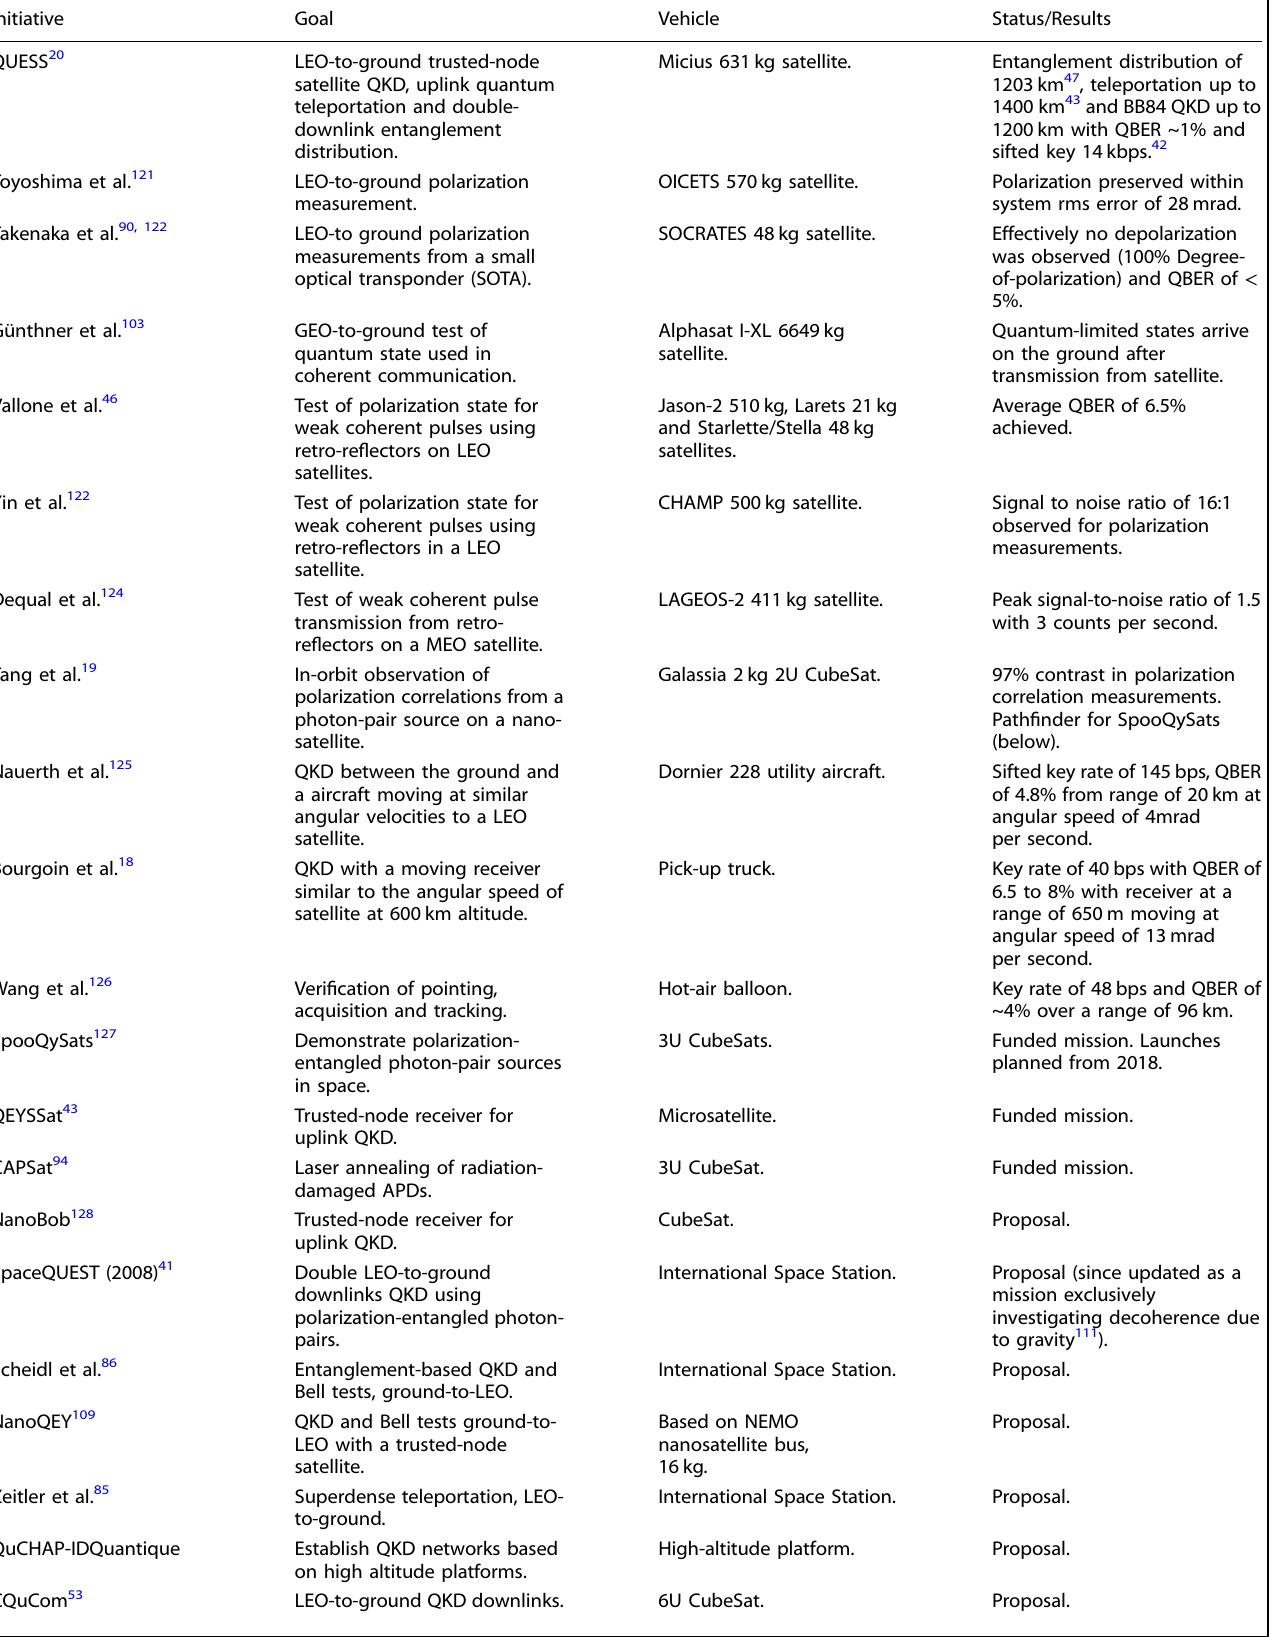
Table 2. A summary of satellite QKD enabling